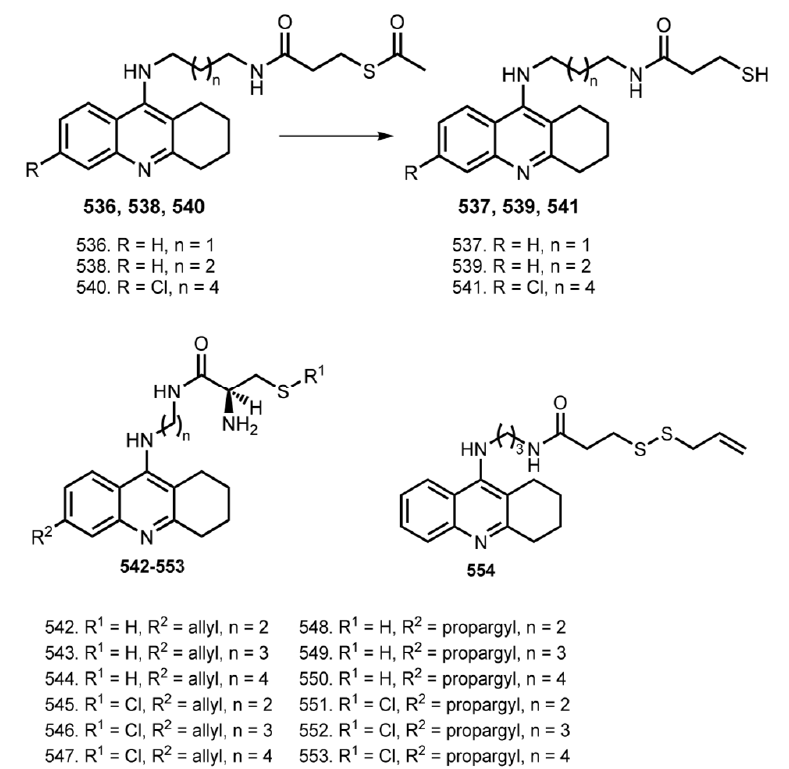
Figure 21. THA derivates conjugated with mercapto group 536 – 541 , designed by Wang et al. [88], THA and 6-Cl-THA–based hybrids 542 – 553 with allyl and propargyl derivatives of cysteine [89], hybrid with H 2 S-releasing moiety 554 [90].